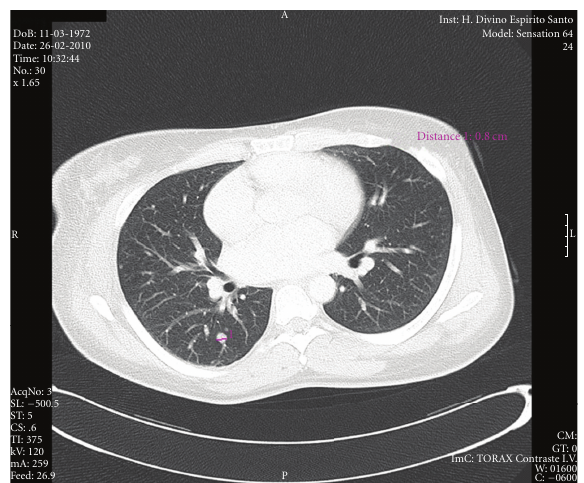
Figure 2: Thoracic CT scan. Multiple micronodules are visualized in peripheral topography, more numerous at the right lung, where an 8 mm nodule can be identified in the apical segment of the inferior lobe, with topography and morphology suggestive of